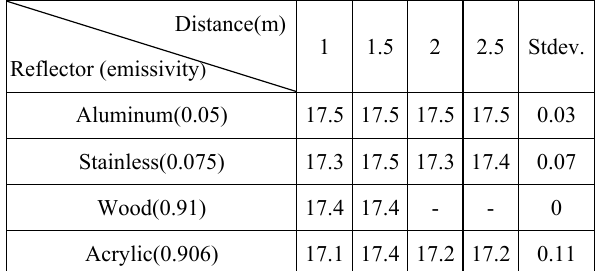
5.1 Results of Distance between Target and